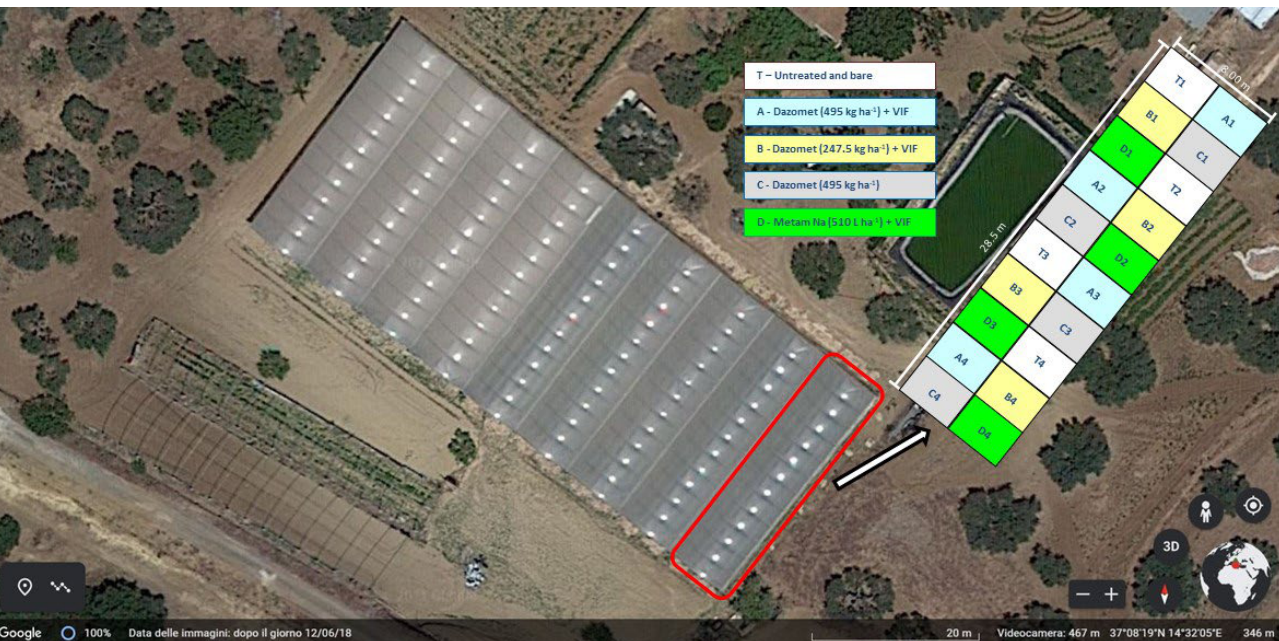
Figure 1. Location and experimental scheme adopted for the first trial (source: https://www.google.it/intl/it/earth/ accessed on July 2018).